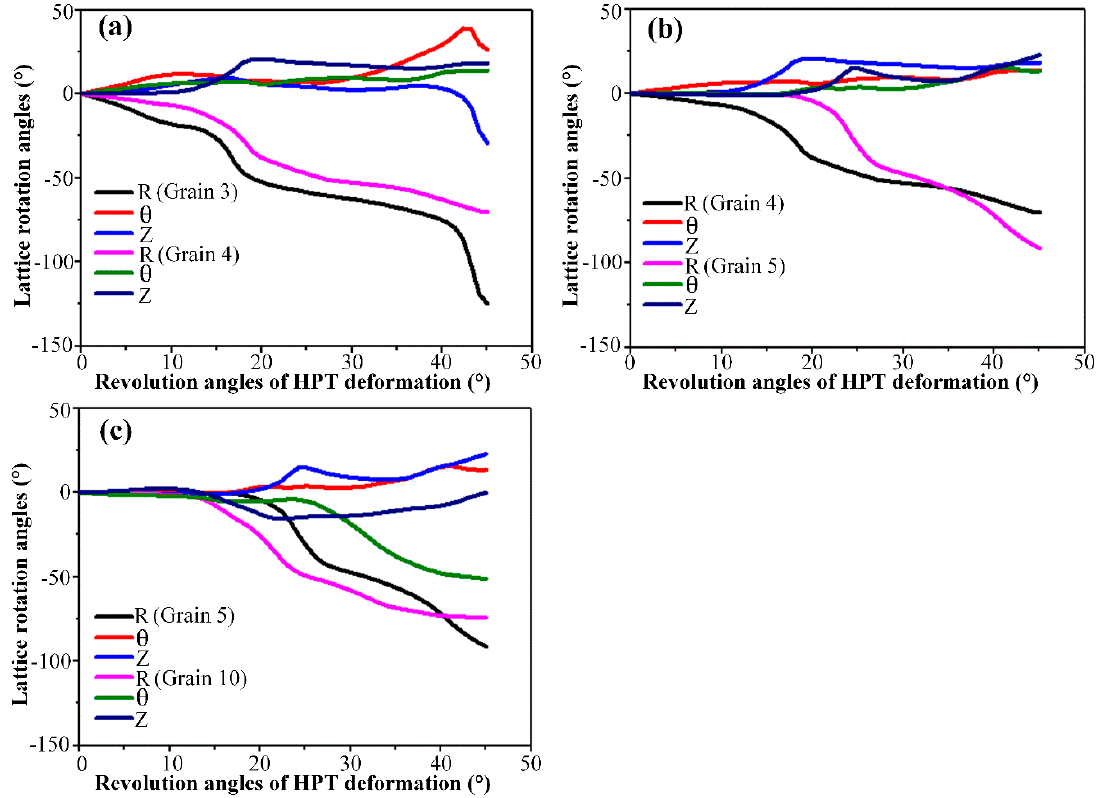
Figure 8. The predicted lattice rotation angles of the detected grains along the axial direction. ( a ) Grains 3 and 4, ( b ) Grains 4 and 5 and ( c ) Grains 5 and 10.